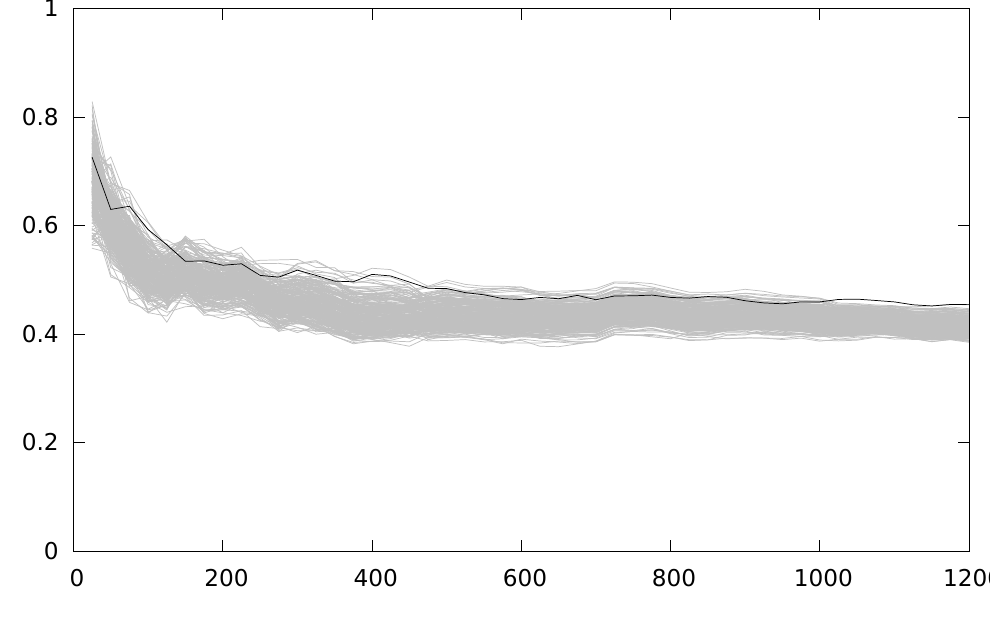
Figure 6. Maximum correlation for different key guesses vs . number of power traces with a partial loop unrolling of 2 iterations with